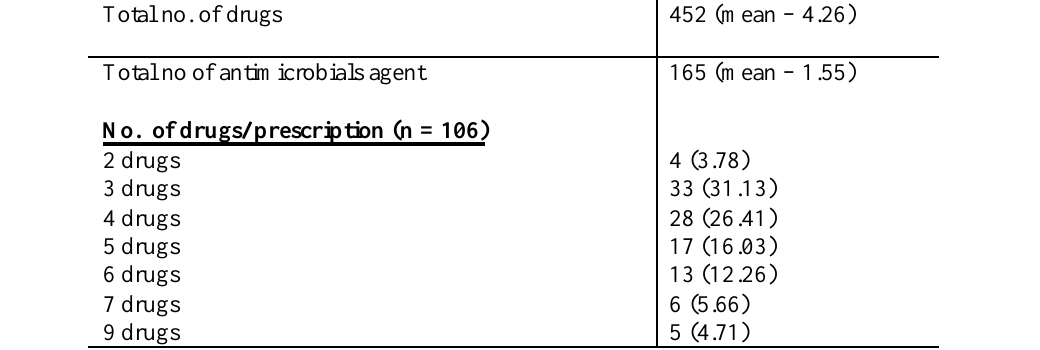
Table IV : Antimicrobial Indication and Duration